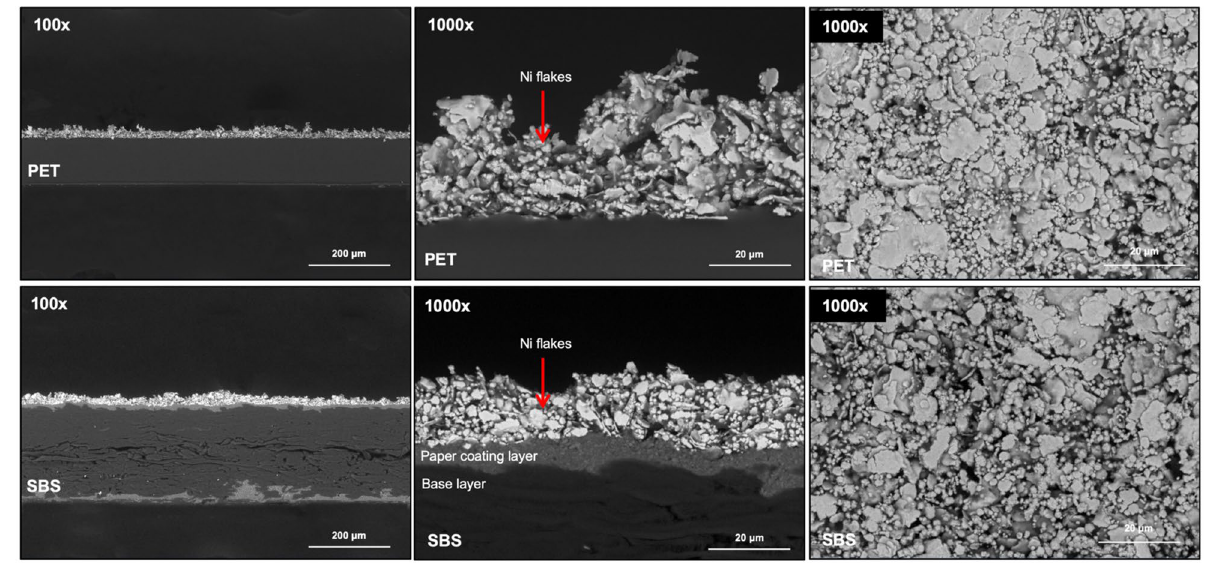
Figure 10. SEM microstructure images of the printed Ni ink at 100 × and 1000 × magnifications.